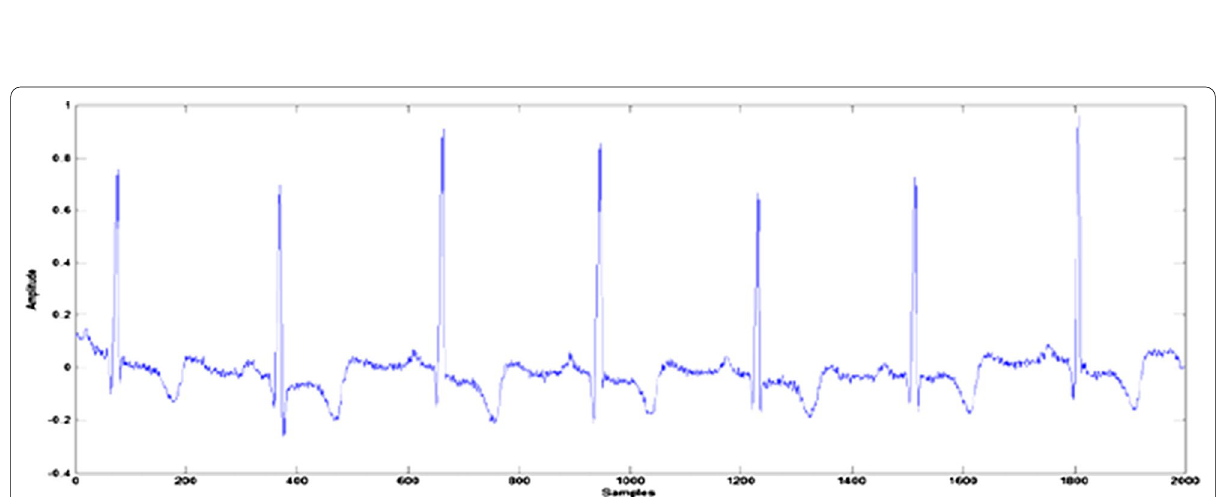
Fig. 8 Raw ECG record number 100 having 2000